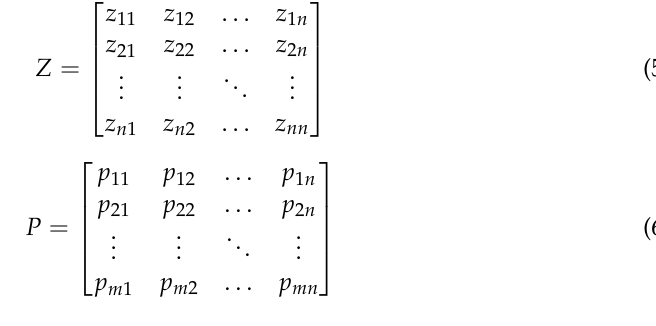
Table 1. Structure of the extended input–output table. Intermediate Use Final Use Sector j:1,2, . . .